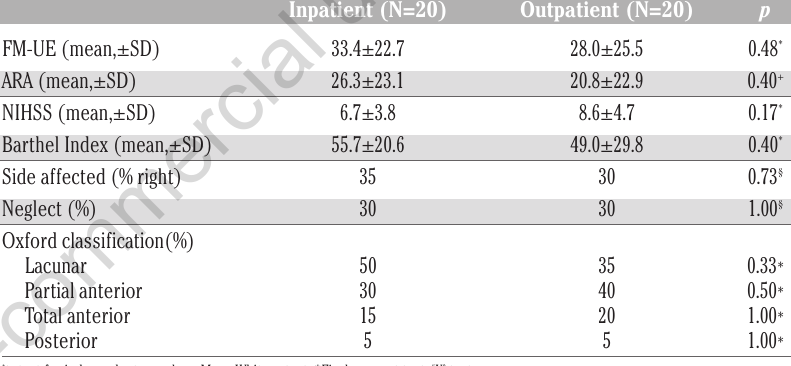
Table 2. Clinical/neurological status at the time of study enrollment.